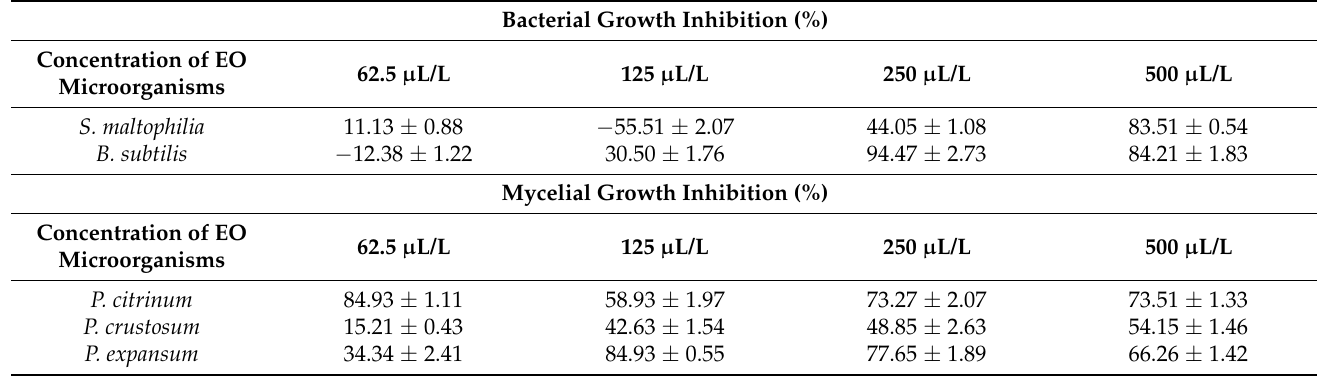
Table 3. In situ analysis of the antibacterial activity of the vapor phase of T. serpyllum essential oil in bread. Bacterial Growth Inhibition (%)